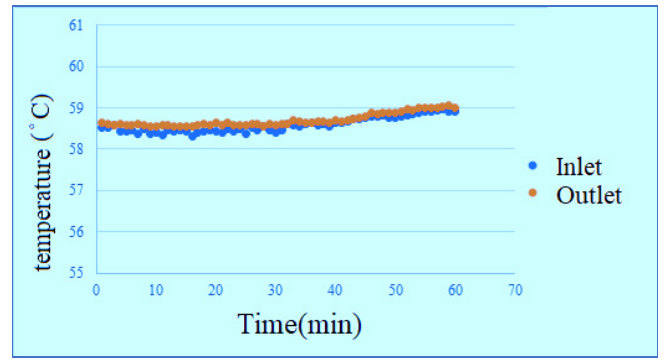
Figure 17. High-temperature high-flow outlet/inlet temperature curve diagram.